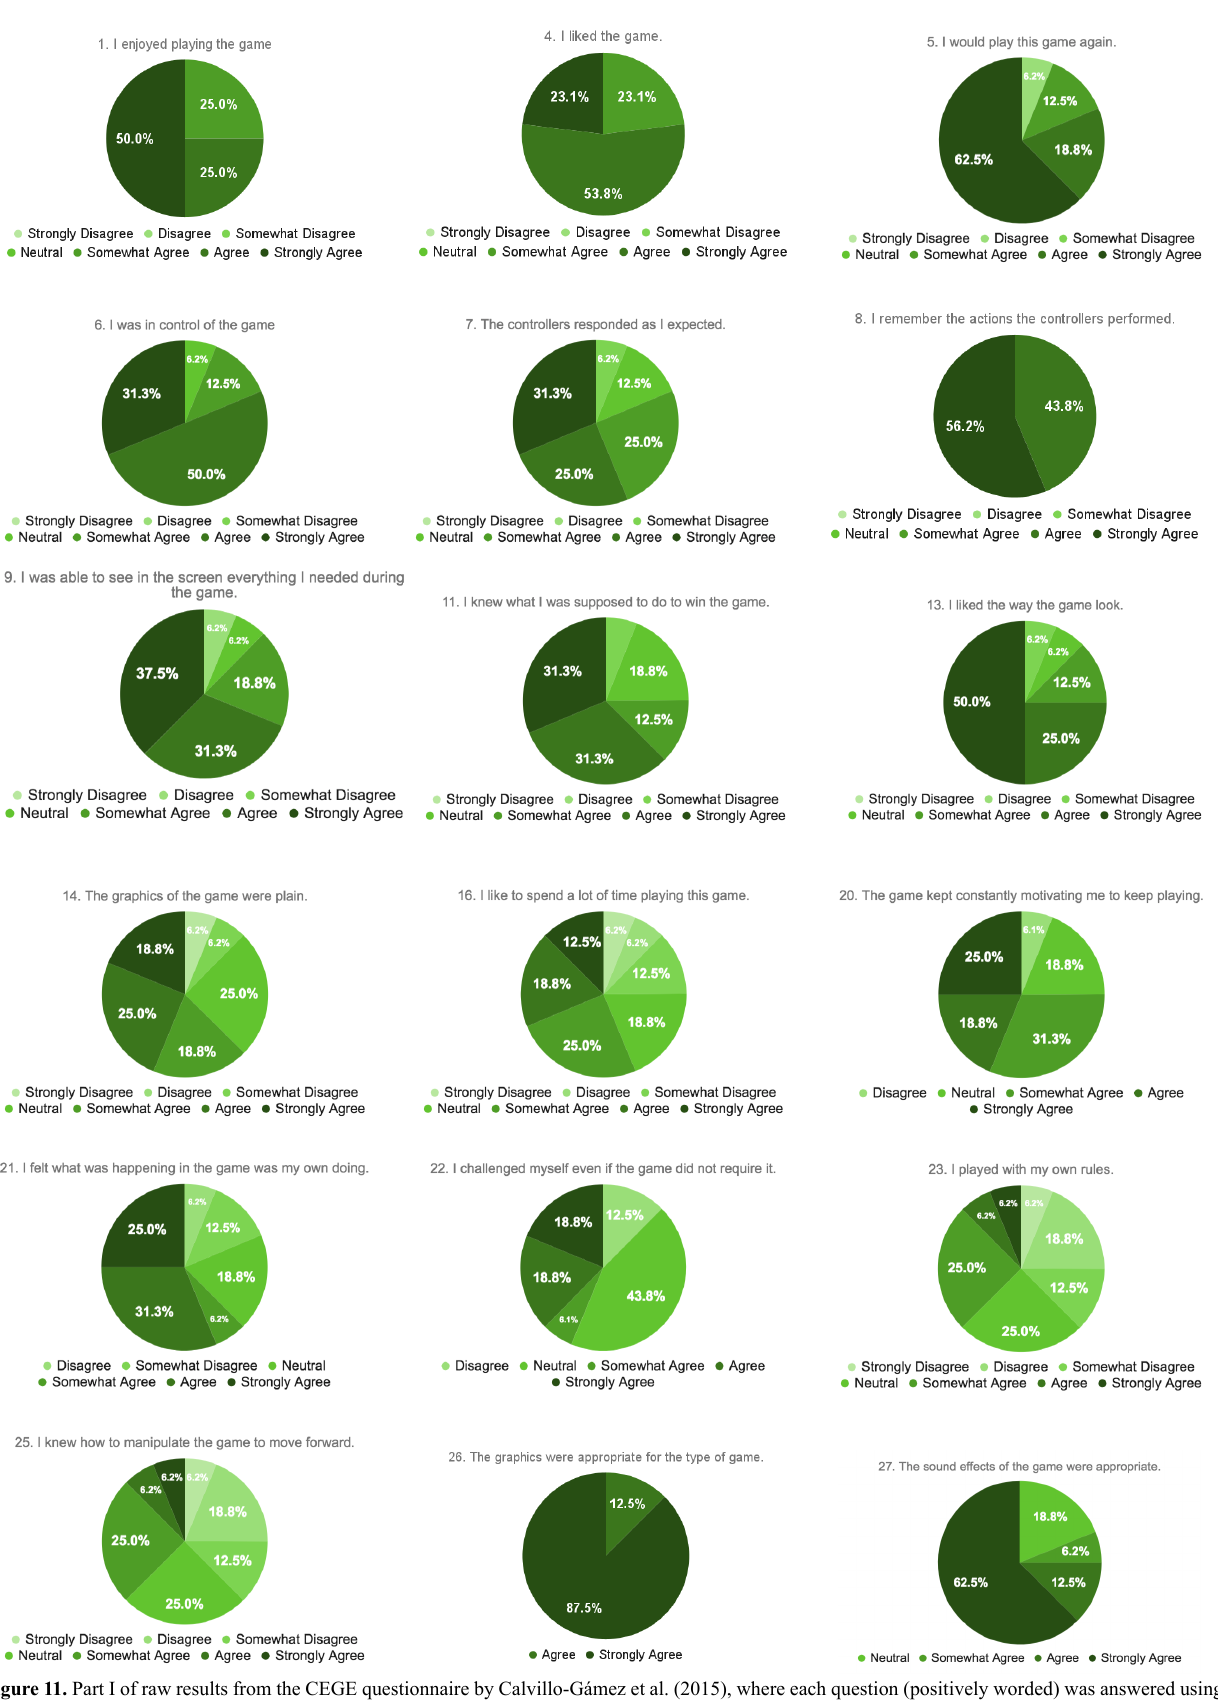
Figure 11. Part I of raw results from the CEGE questionnaire by Calvillo-Gámez et al. (2015), where each question (positively worded) was answered using a 7-point Likert